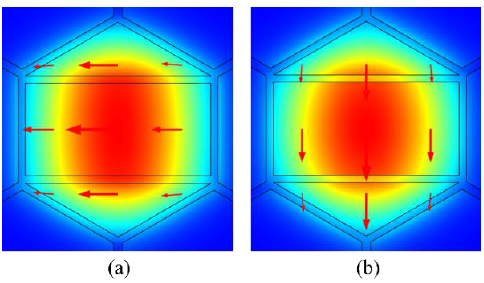
Figure 3. Mode field distribution of the designed MSF for ( a ) x polarization and ( b ) y polarization in the tested frequency